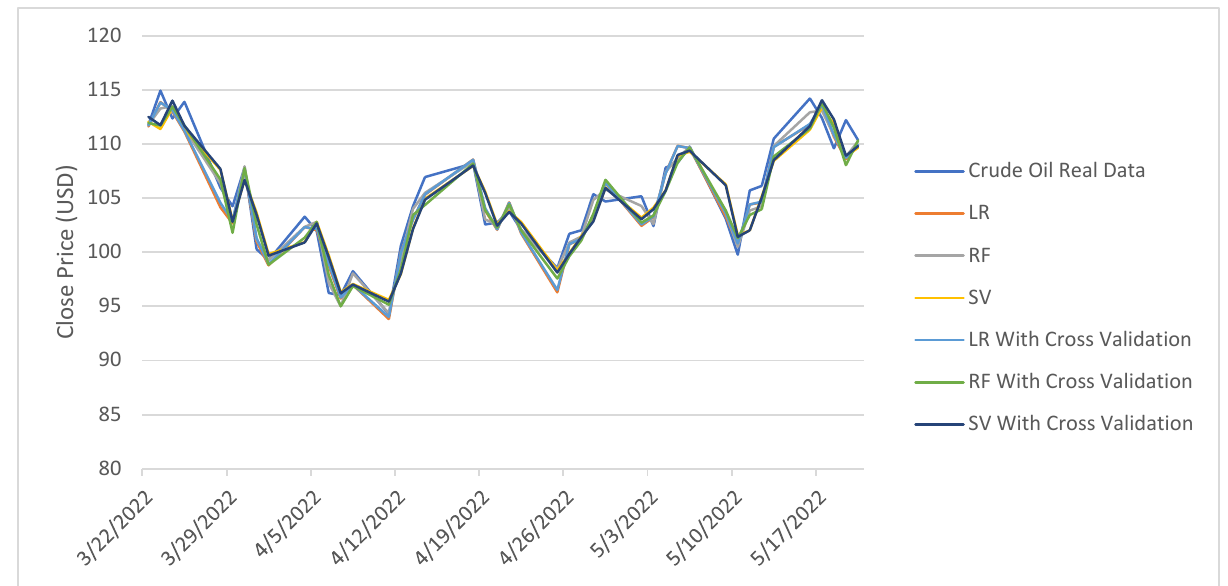
Figure 4. Results for two months with the effect of war.